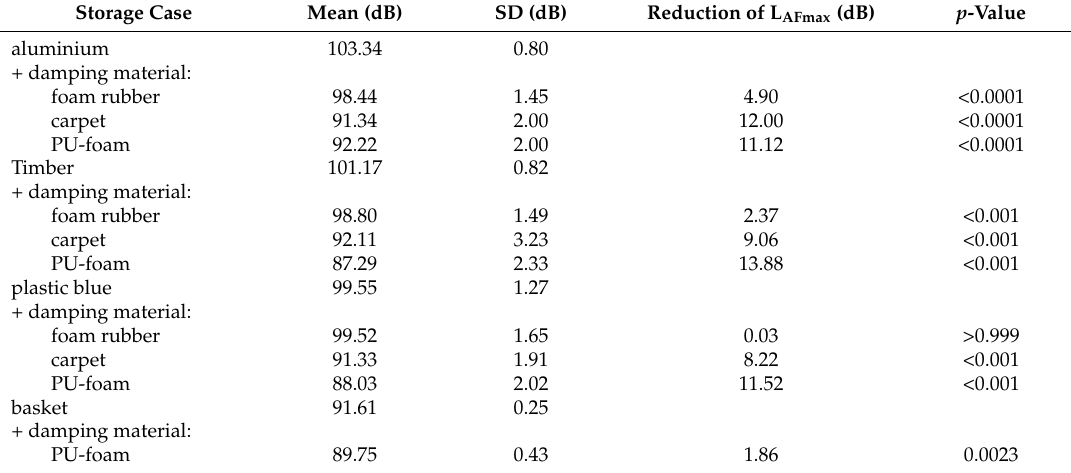
Table 2. Acoustic effects of different damping materials applied to storage cases “aluminium”, “timber”, “plastic blue”, and “basket”. Statistical significance analyses were performed with n = 25 and using a paired sample t -test with Welch